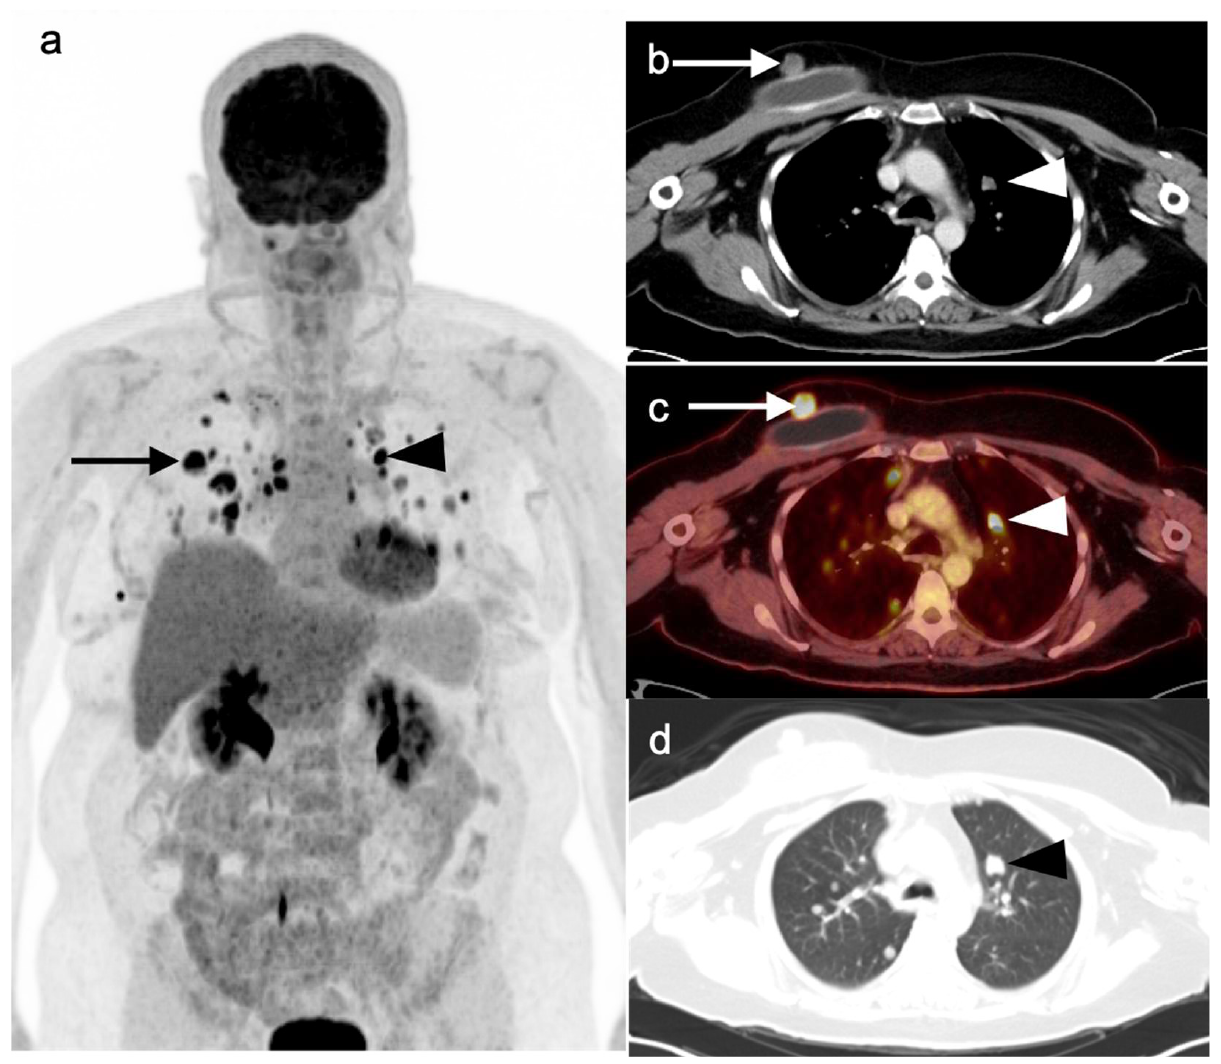
Figure 22. A 58-year-old female with histologically proven malignant phyllodes tumor of the right breast with biopsy-proven pulmonary metastases consistent with hematologic spread of malignancy to the lungs. MIP image ( a ) demonstrates the primary malignant phyllodes tumor of the superior right breast ( black arrow ) and abnormal focal uptake within greater than 10 bilateral lung metastases (representative black arrow). Axial CT with soft tissue windowing ( b ), fused PET/CT ( c ), and axial CT with lung windowing ( d ) show the right superior breast malignant phyllodes tumor ( white arrow on b , c ) superior to a right breast implant) and representative left upper lobe lung metastasis ( arrowheads in c , d ).